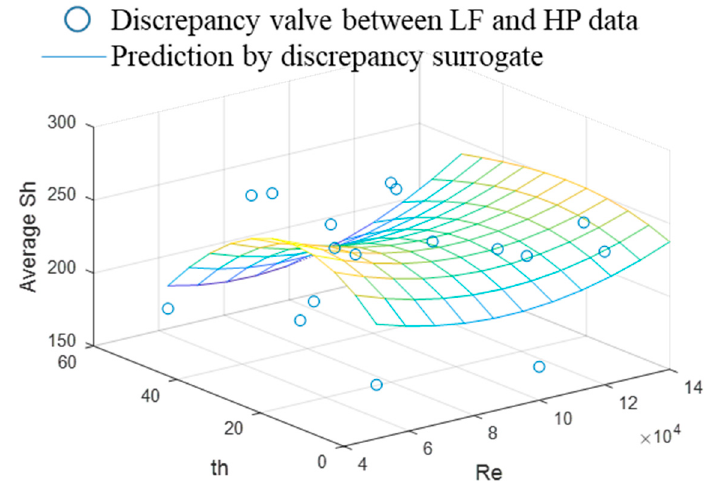
Figure 9. Discrepancy surrogate for the